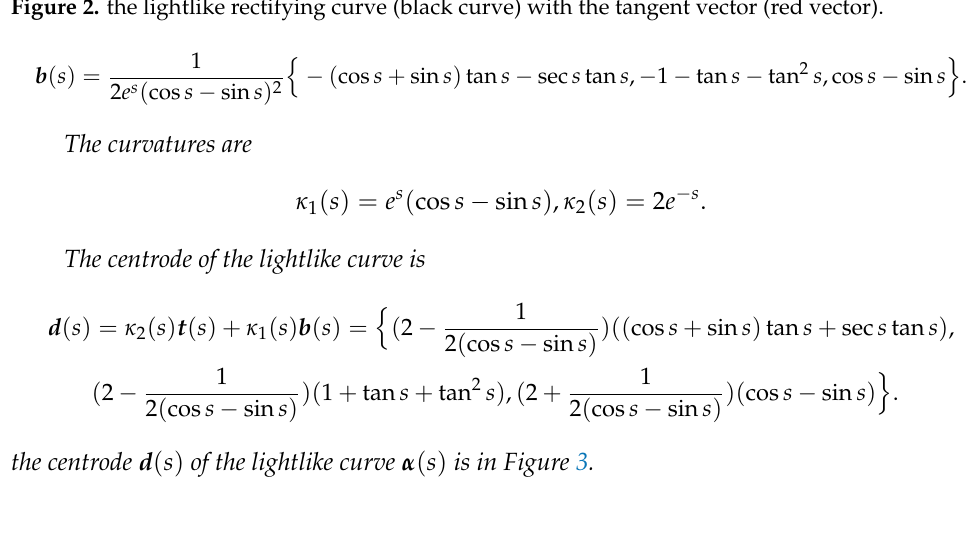
Figure 2. the lightlike rectifying curve (black curve) with the tangent vector (red